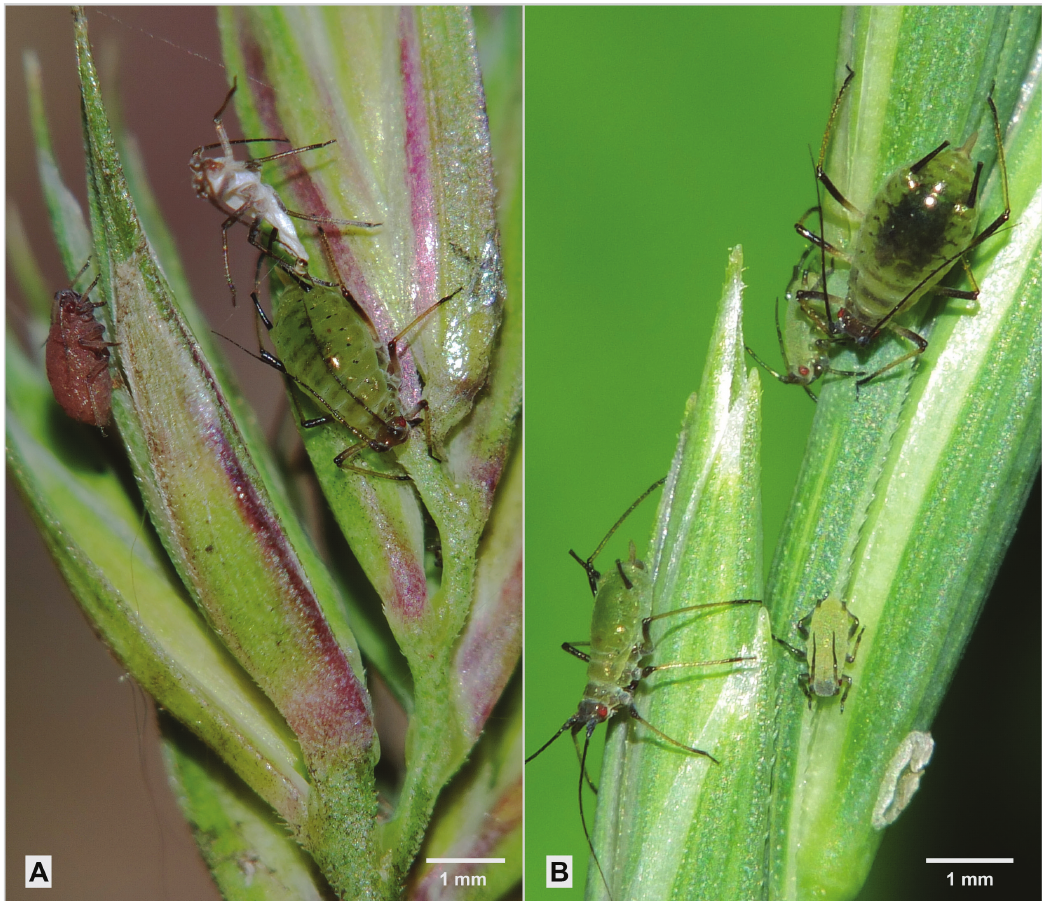
Fig. 27. Sitobion avenae (Fabricius, 1775). Apterae and juveniles on A . Dactylis glomerata and B . Elytrigia repens